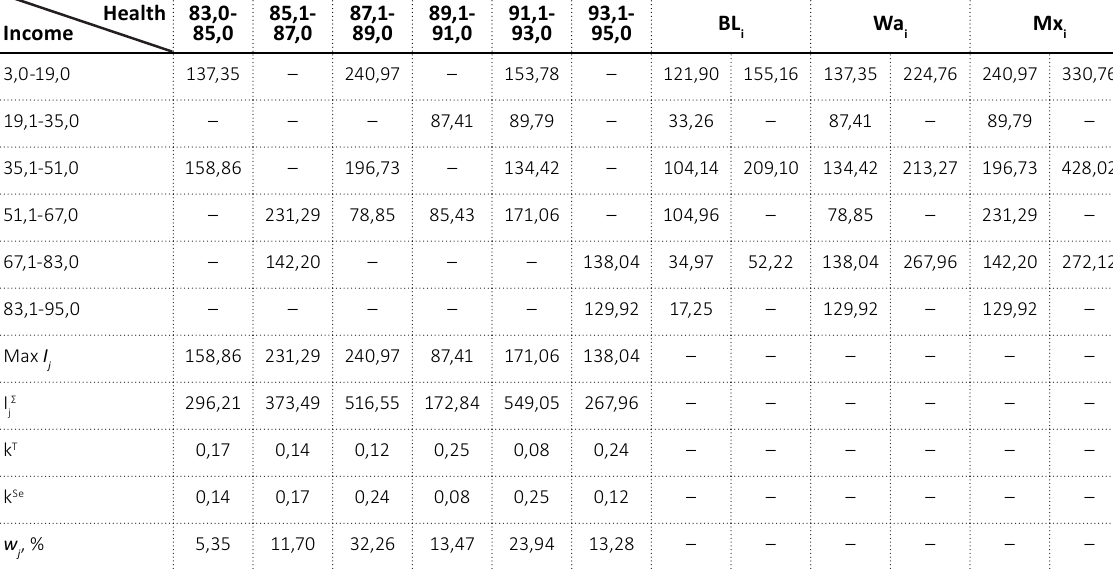
Table 4. Payoff matrix: Bayes-Laplace’s criterion, Wald’s criterion, Maximax